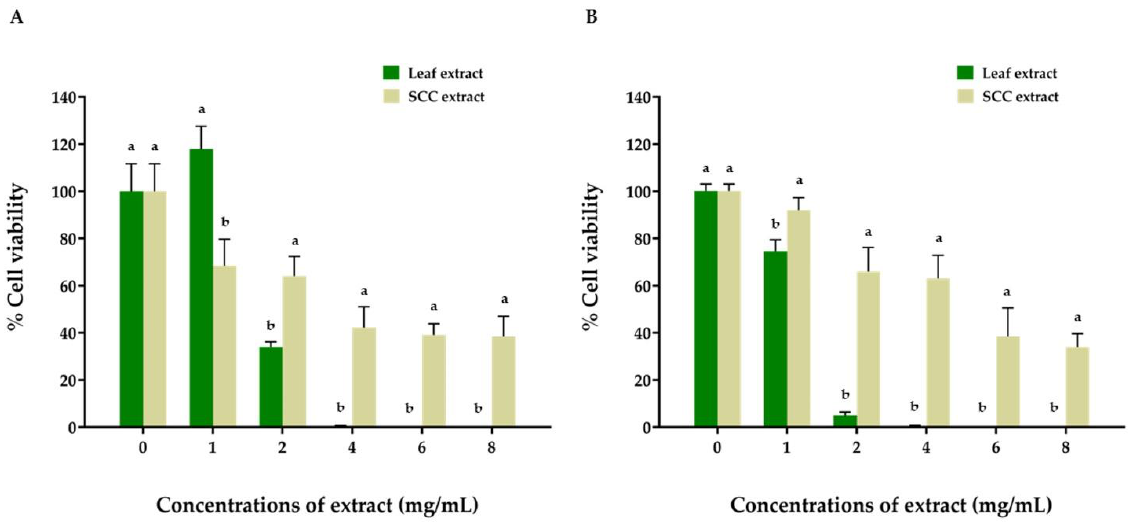
Figure 6. Oral cancer cell viability after treatment with ethanolic leaf and SCC extracts of R. nasutus : ( A ) ORL-48 cell line and ( B ) ORL-136 cell line. The data are presented as the means ± SD of the results of triplicate determinations. Bars with different letters at each concentration are significantly different according to an independent-samples t test at p ≤